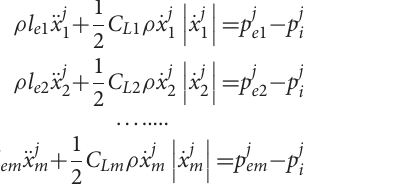
FIGURE 6 | The (A) measured displacements of Product 3 (triple layer, fiberglass, and 25-gauge steel door with U-bar reinforcement) just prior to failure, and (B) photographs of mounting hardware pull-out and bending.